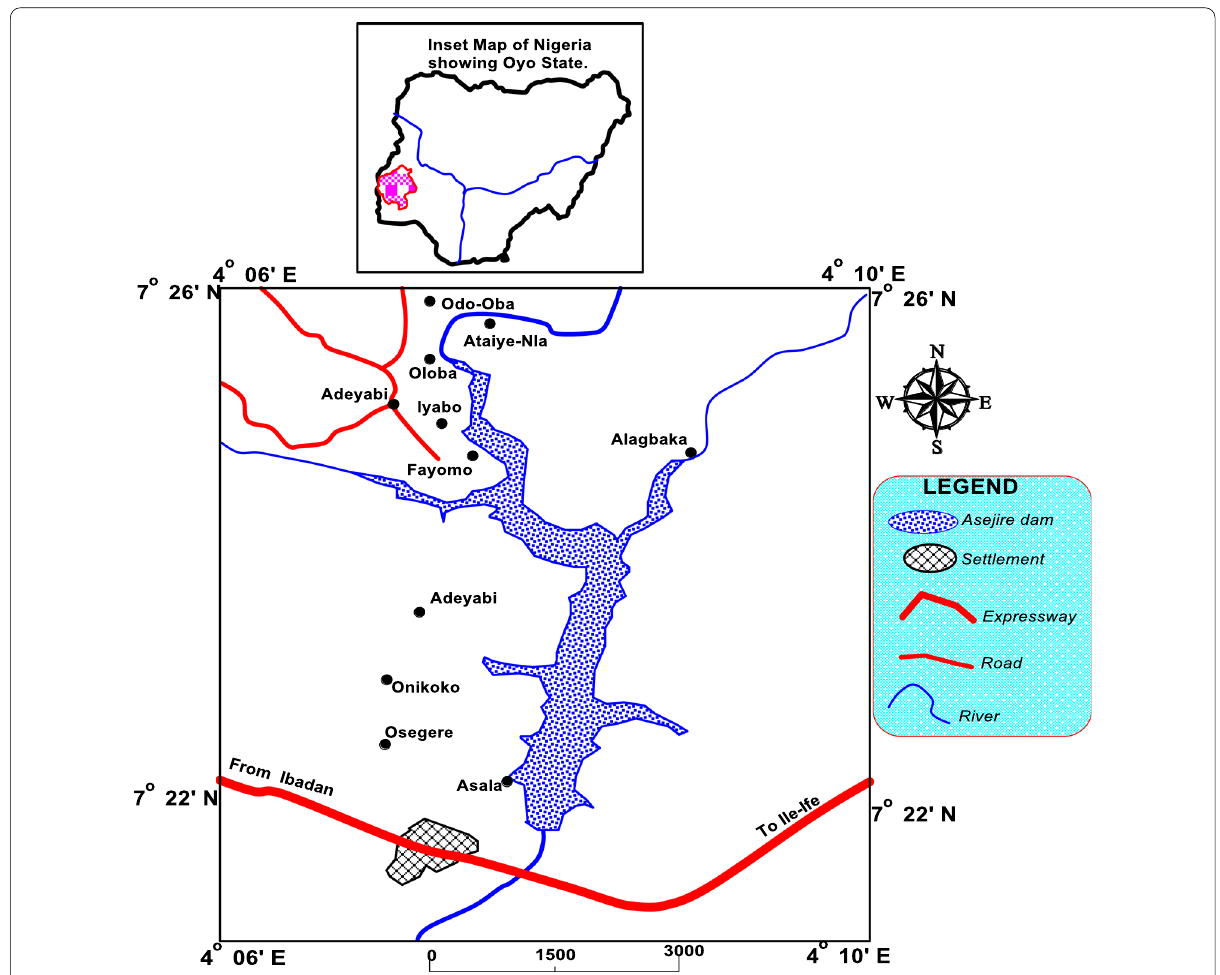
Fig. 1 Map of Asejire